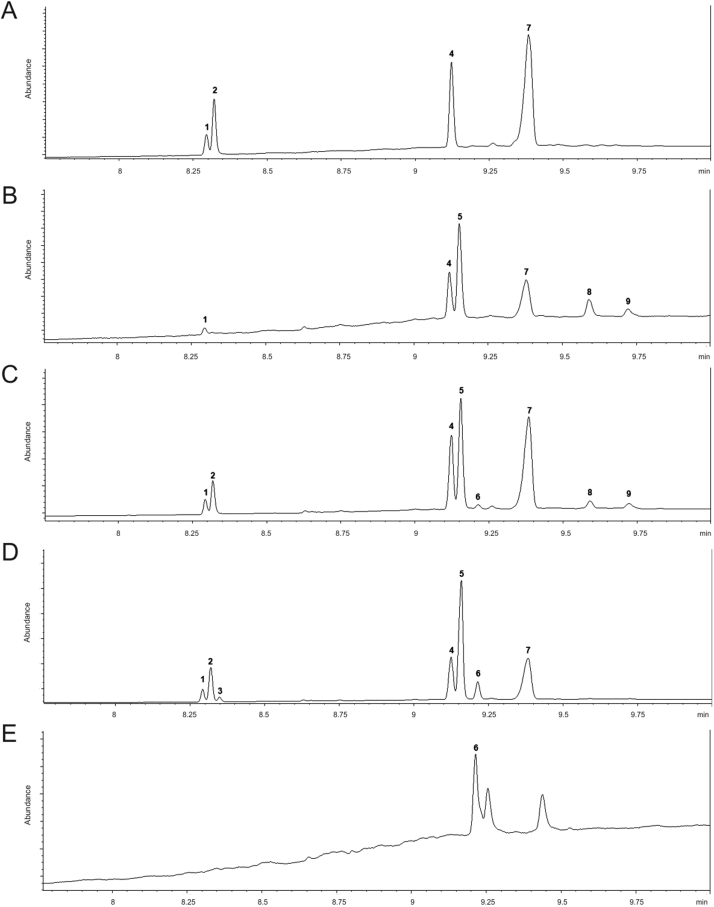
GC-FID chromatograms of P. pastoris extracts after 72 h of induction. A: strain PpPIS1-ERG1/SHC B: strain PpPIS1-ERG1/TC C: PpPIS1-ERG1/SHC/TC D: strain PpPIS1-ERG1/TC-D373C E: authentic ambergris sample. Compounds detected in cell extracts: squalene (1), 3-deoxyachilleol (2), presumably bicyclic squalene derivative (3), cholesterol-TMS ether (4, internal standard), 8α-hydroxypolypoda-13,17,21-triene (5), (+)-ambrein (6), ergosterol-TMS ether (7), 14β-hydroxyonocera-8(26)-ene (8), onoceranoxide (9).